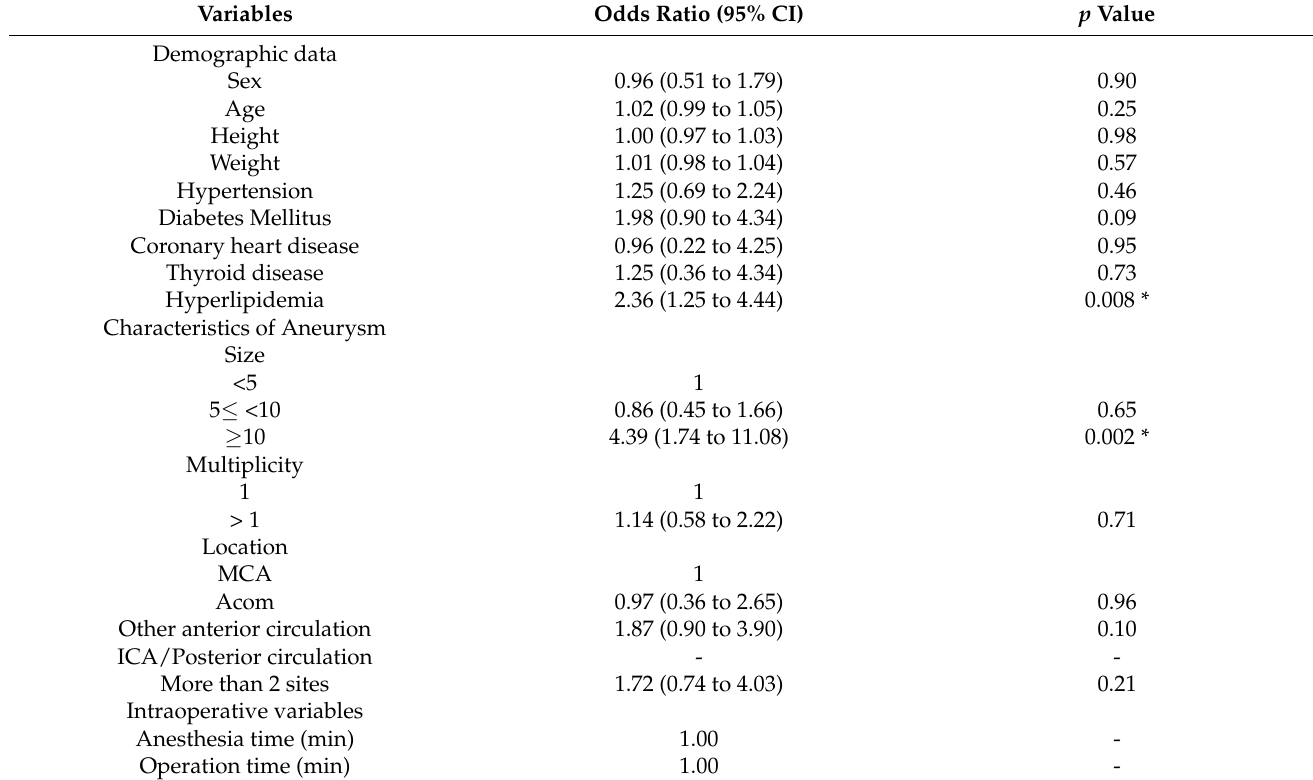
Table 3. Univariate logistic regression analysis of risk factors for postoperative neurological